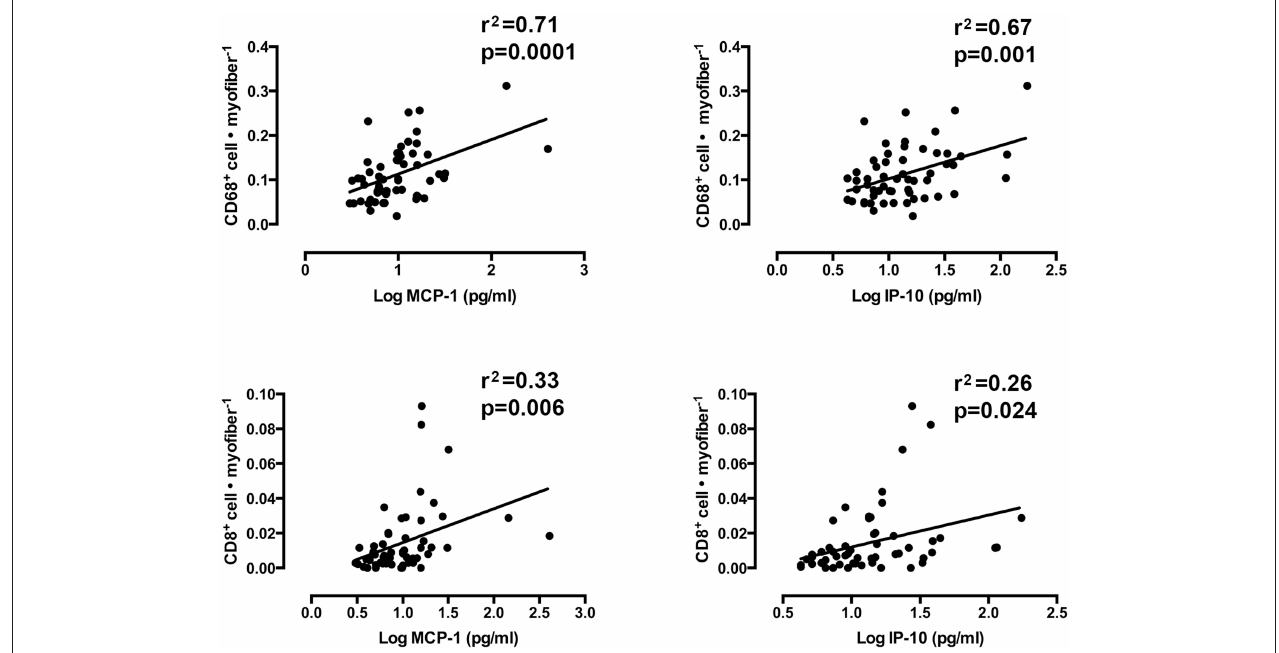
FIGURE 6 | The association between the number of muscle-infiltrating CD68 + macrophages and CD8 + T-cells and the protein content of monocyte chemoattractant protein 1 (MCP-1) and interferon gamma-inducible protein 10 (IP-10). (Mixed models linear regression, α = 0.05 ).